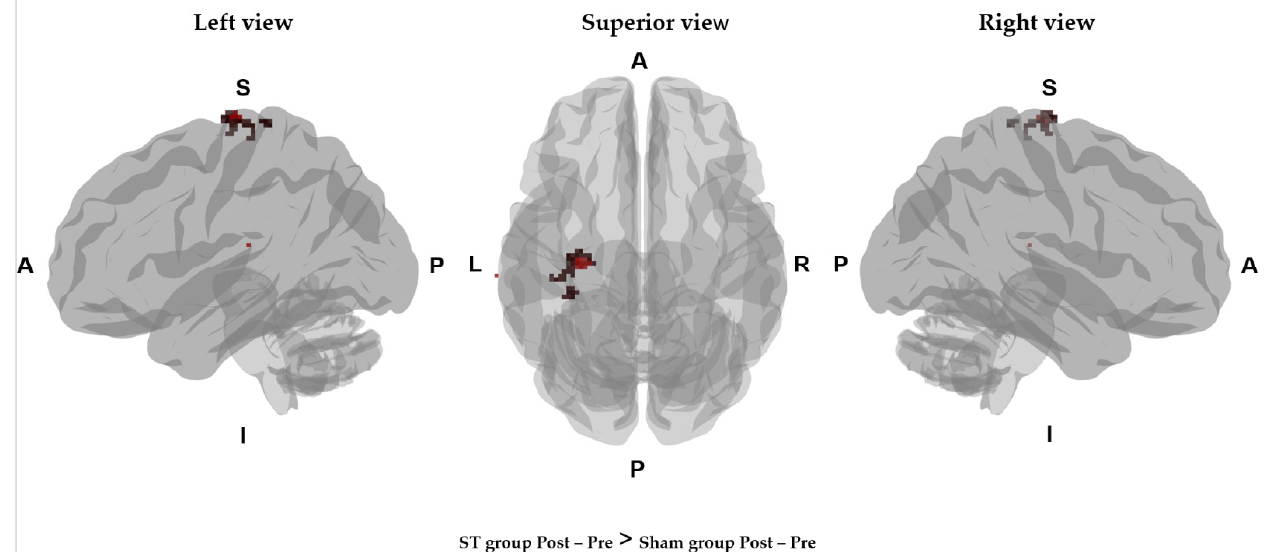
Figure 3. Mapping of the CBV states in the experimental group versus the sham group. The brain regions (the precentral gyrus and postcentral gyrus) marked in red are regions with increased activation after treatment in the ST group compared to the Sham group. A, anterior; P, posterior; L, left; R, right. Table 4. Comparisons CBV clusters between the experimental and sham groups.